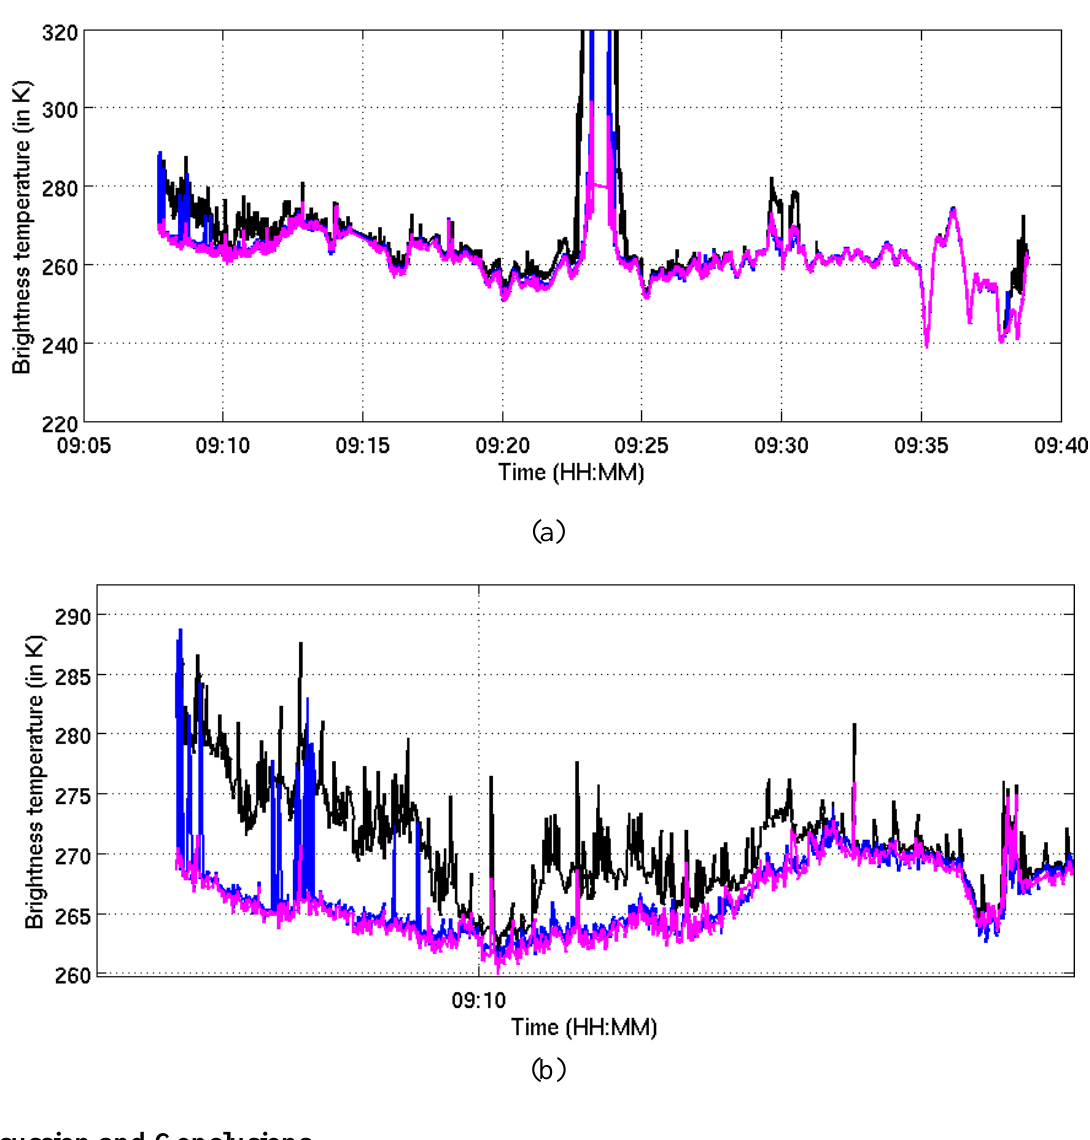
transect. (b) zoom on (a), near to the CEL site. The spectra are divided into 8 sub-bands in this figure. Black curve: no-blanking, blue: kurtosis, magenta: Euclidian